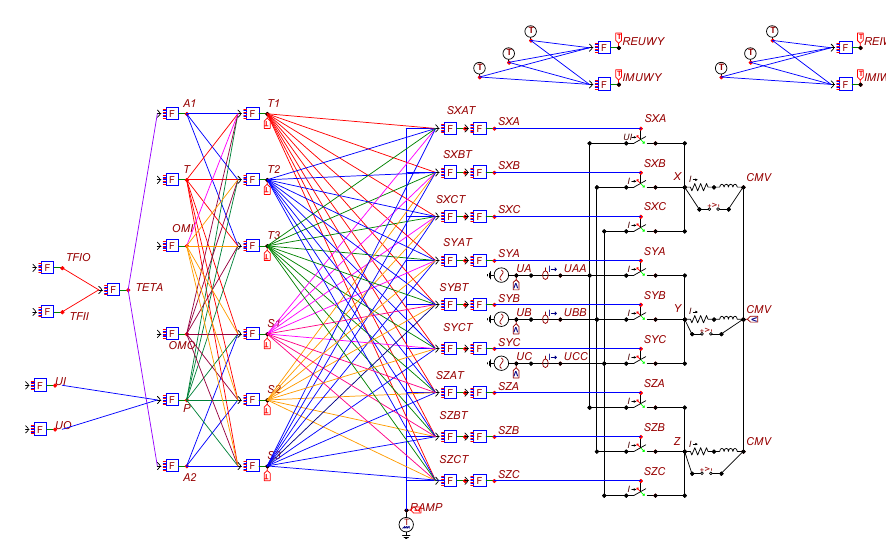
Figure 7. Simulation model of three-to-three-phase MC controlled with usage of the proposed modulation method.